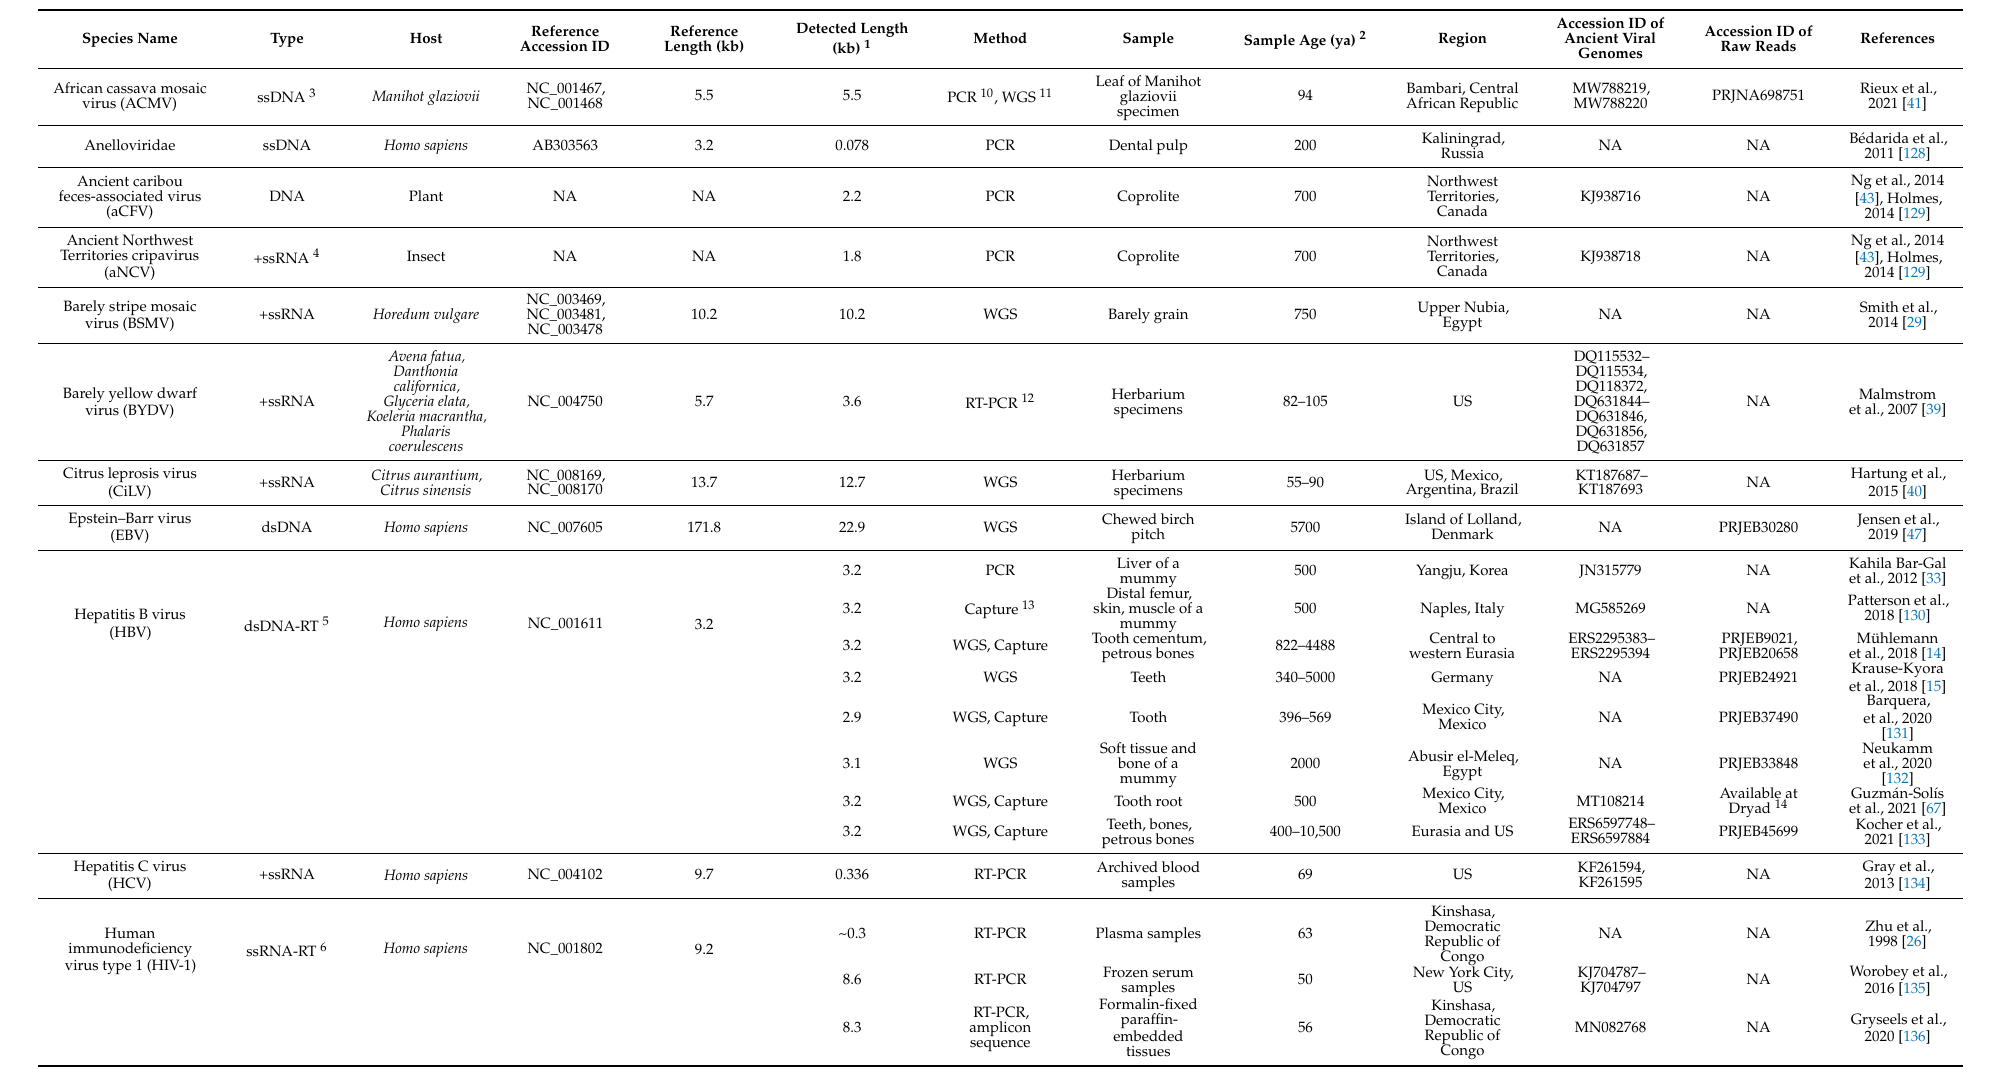
Table 1. Overview of ancient viruses detected from historical